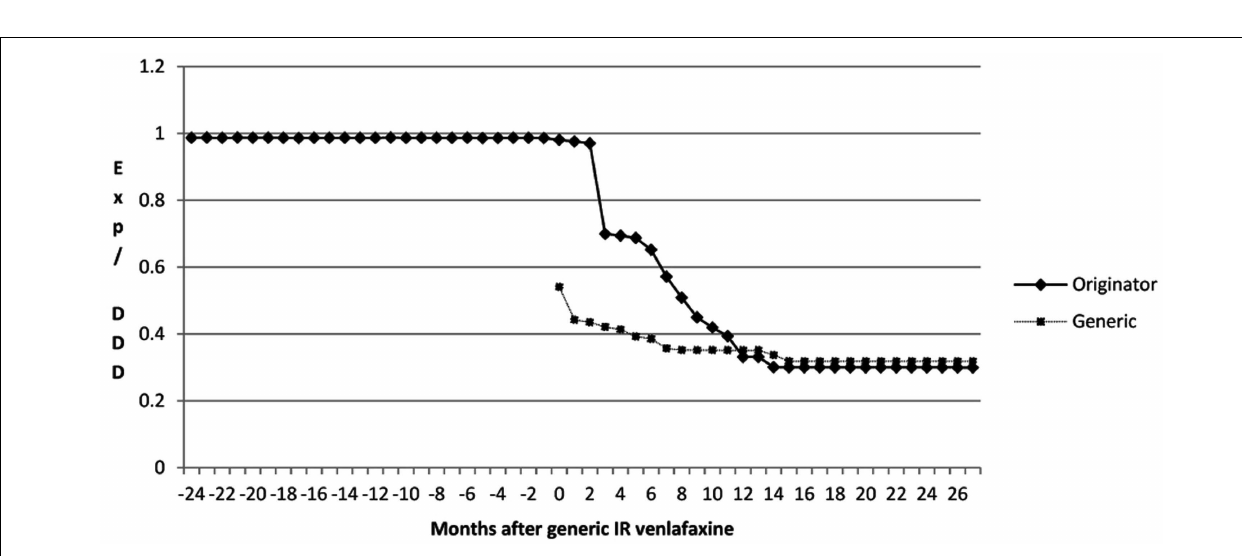
FIGURE 2 |Total expenditure on antidepressants inAustria before and after the availability of generic ER venlafaxine (May 2009).